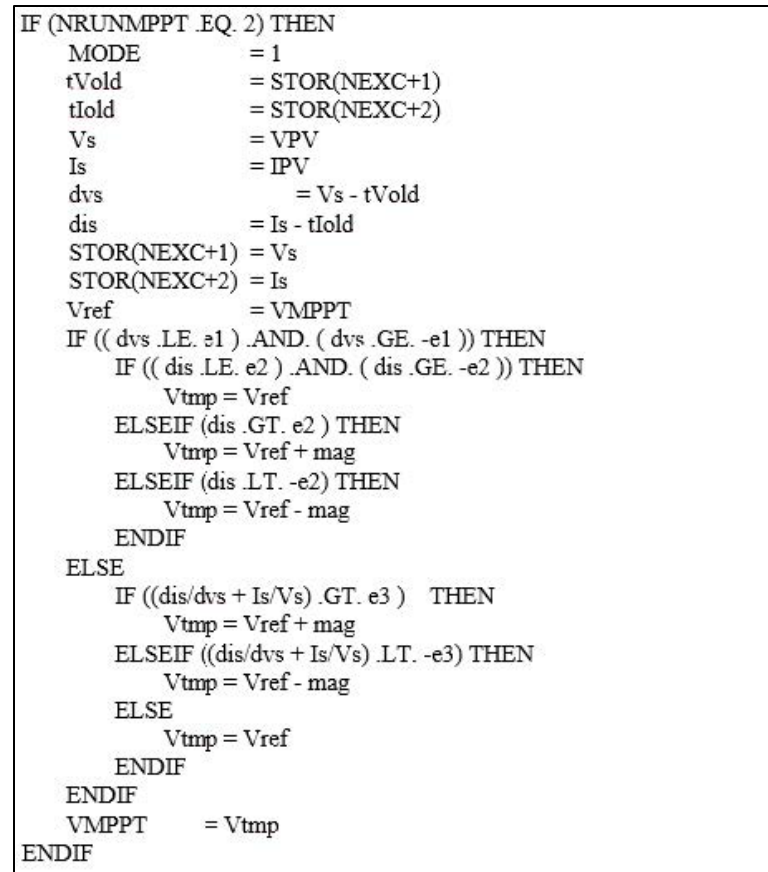
Figure 24. Maximum power point tracking (MPPT) modeling of Fortran language.